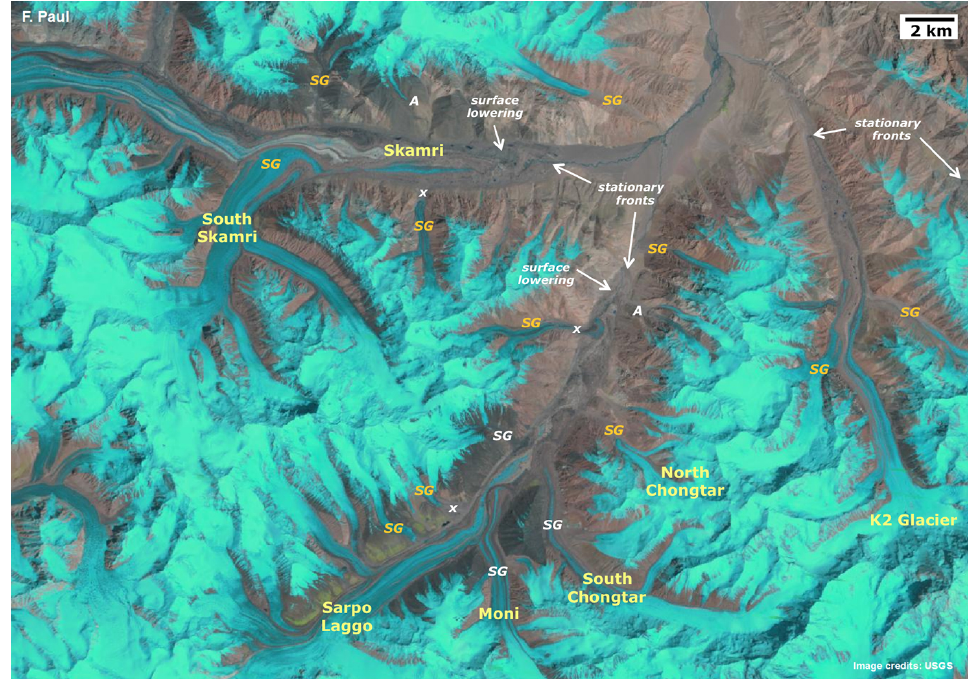
Figure 4. Subregion (3) (Skamri) shows the region between Skamri and Sarpo Laggo glaciers; annotations and Landsat scene as in Fig. 2.